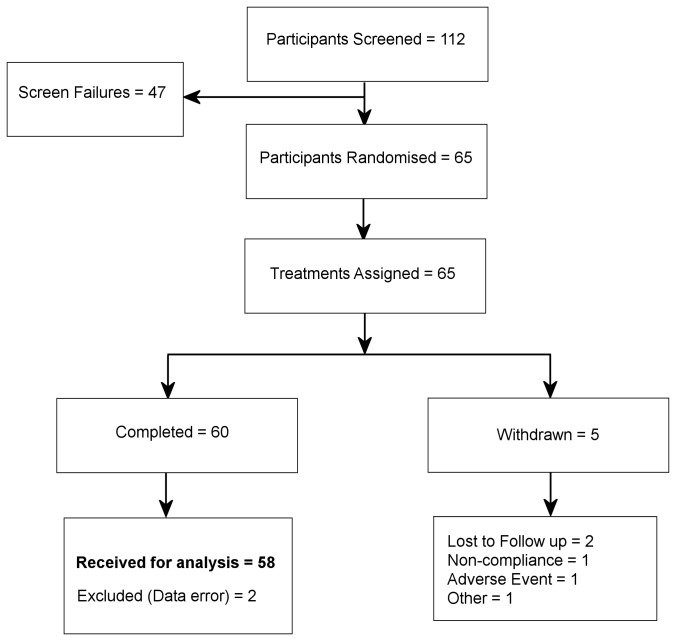
Trial Profile Plot.